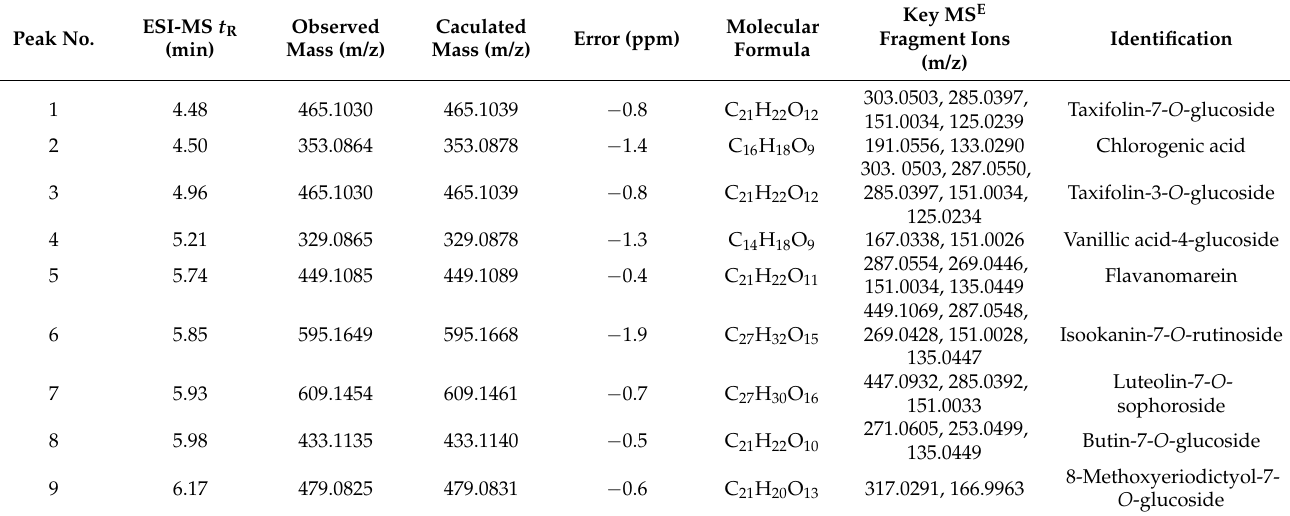
Table 2. Characterization and tentative identification of metabolites found in original and mutant cultivars of Coreopsis rosea and Coreopsis verticillata using ultra-performance liquid chromatography time-of-flight mass spectrometry (UPLC-QTof MS). Peak